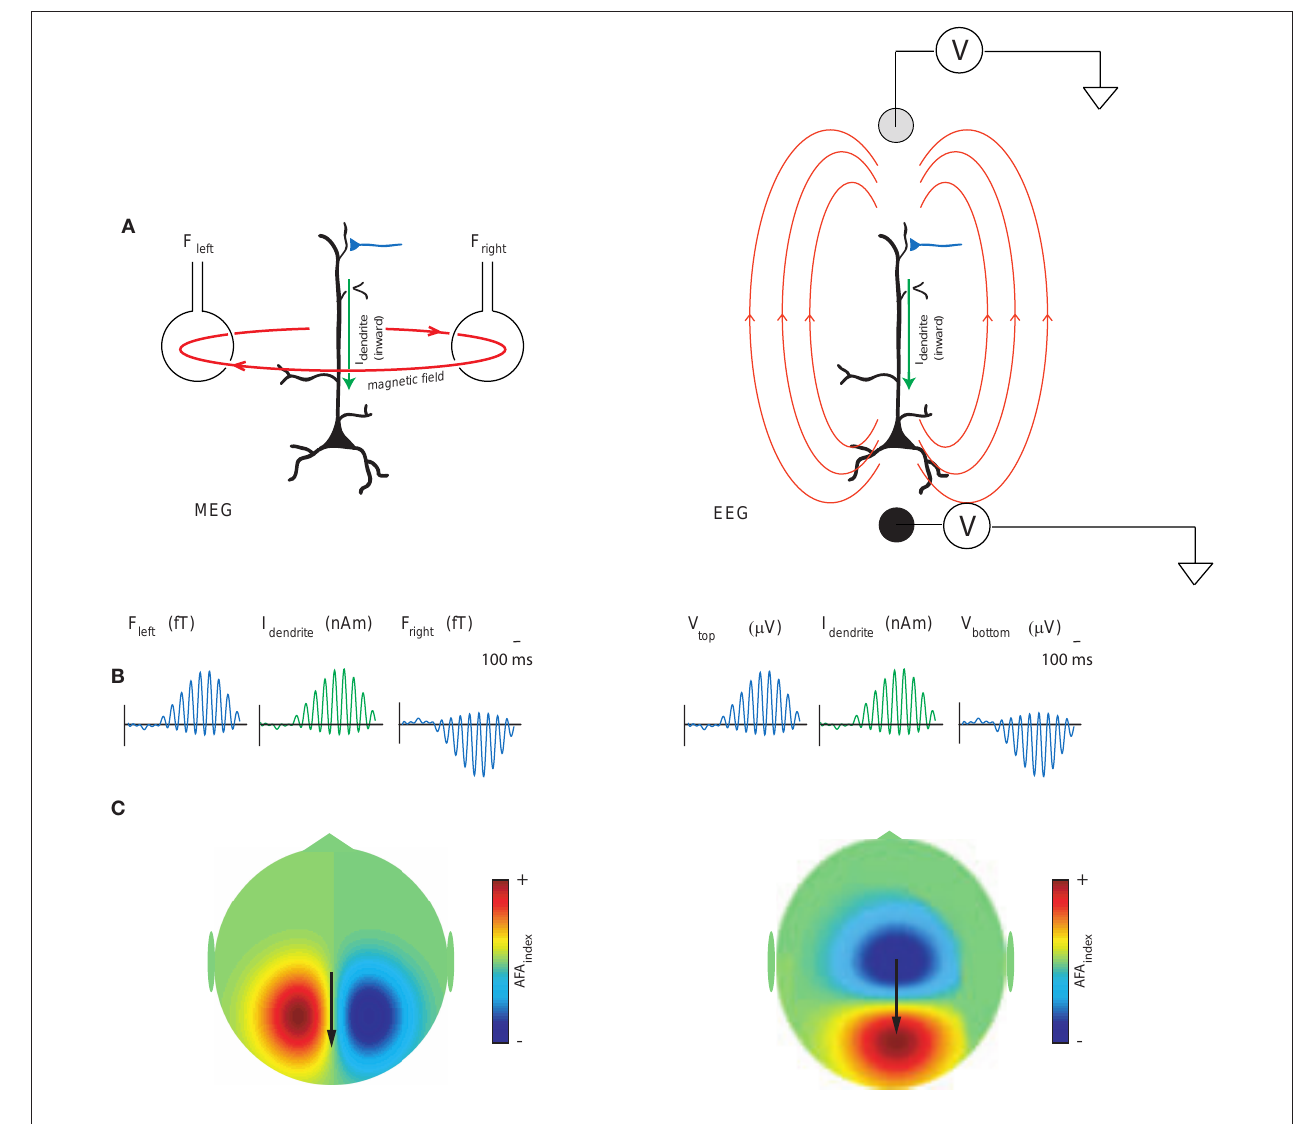
that the amplitude modulations of the oscillatory activity are asymmetric such that the peaks are modulated stronger than the troughs. For the 10 Hz alpha activity this is explained by bouts of inward dendritic currents every ∼ 100 ms. (C) The topography of the amplitude asymmetry of the MEG fields and EEG potentials. Adapted and modified from Mazaheri and Jensen